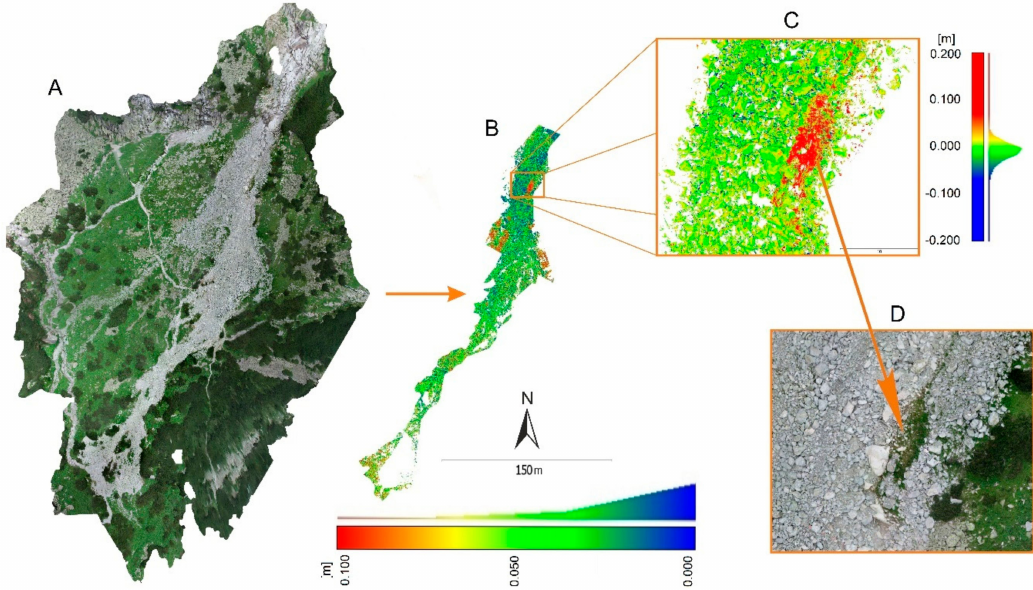
Figure 12. The result of comparing data from terrestrial 3D laser scanning and UAS photogrammetry. ( A ) The whole area of interest (only the talus cone of which was analyzed, the rest containing vegetation was manually removed); ( B ) comparison of the unfiltered clouds showing absolute di ff erences between clouds. ( C ) Detail of the map of positive and negative di ff erences and ( D ) its real color 3D realistic view, from which it is apparent that the di ff erences correspond with remainders of